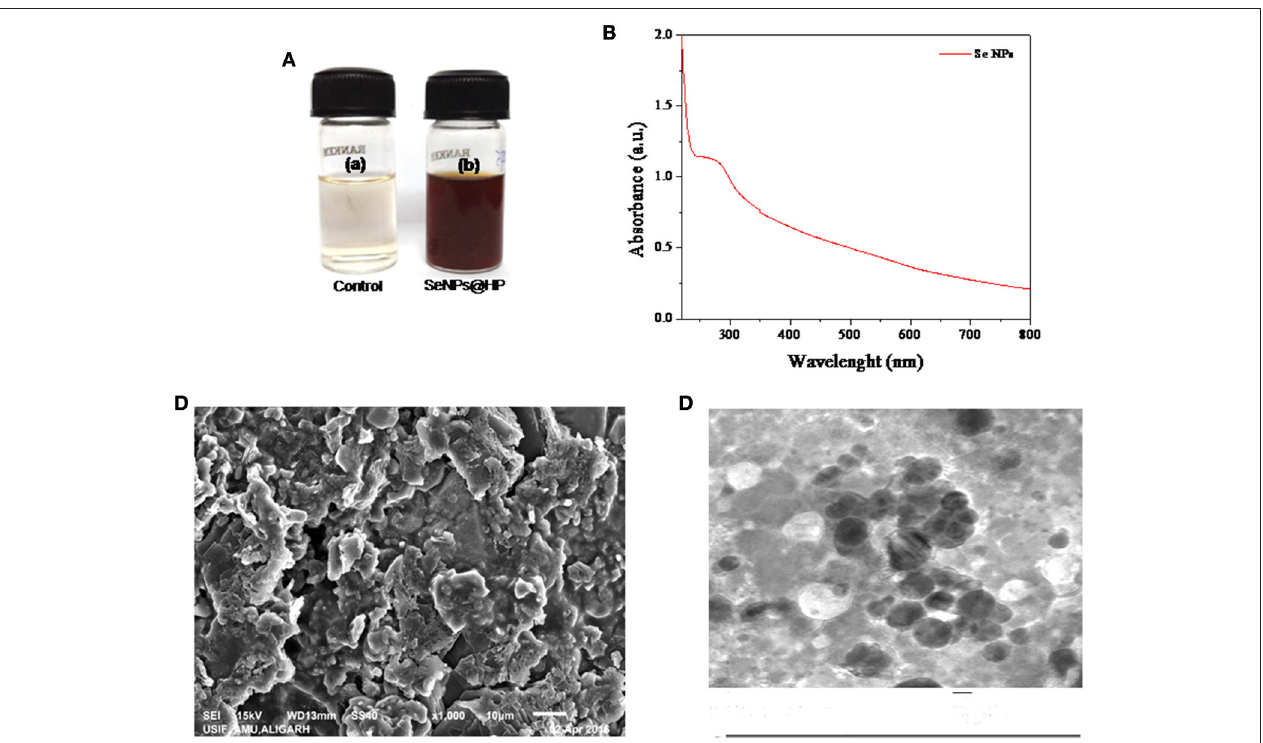
FIGURE 1 | Biofabrication and characterization of SeNPs@HP. (A) Photographs of the results for 30 min storage after the redox reaction in the absence (a) and presence (b) of HP. (B) UV-vis spectrum of SeNPs@HP. (C) SEM image of SeNPs@HP, which shows the formation of aggregates. (D) TEM image of SeNPs@HP. The particles were almost spherical in shape and the particle size ranged from 12 to 15nm.